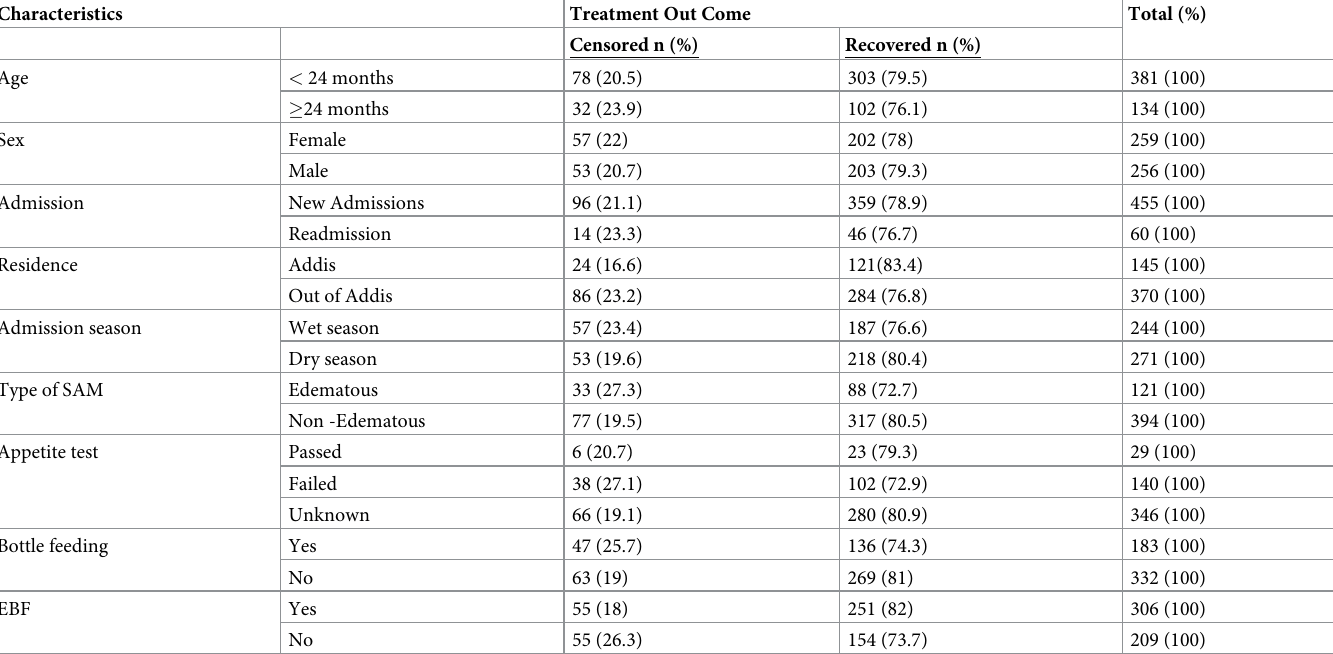
Table 1. Socio-demographic and admission characteristics of children with SAM admitted in SPHMMC from 2012 to 2019, Addis Ababa, Ethiopia (n = 515).